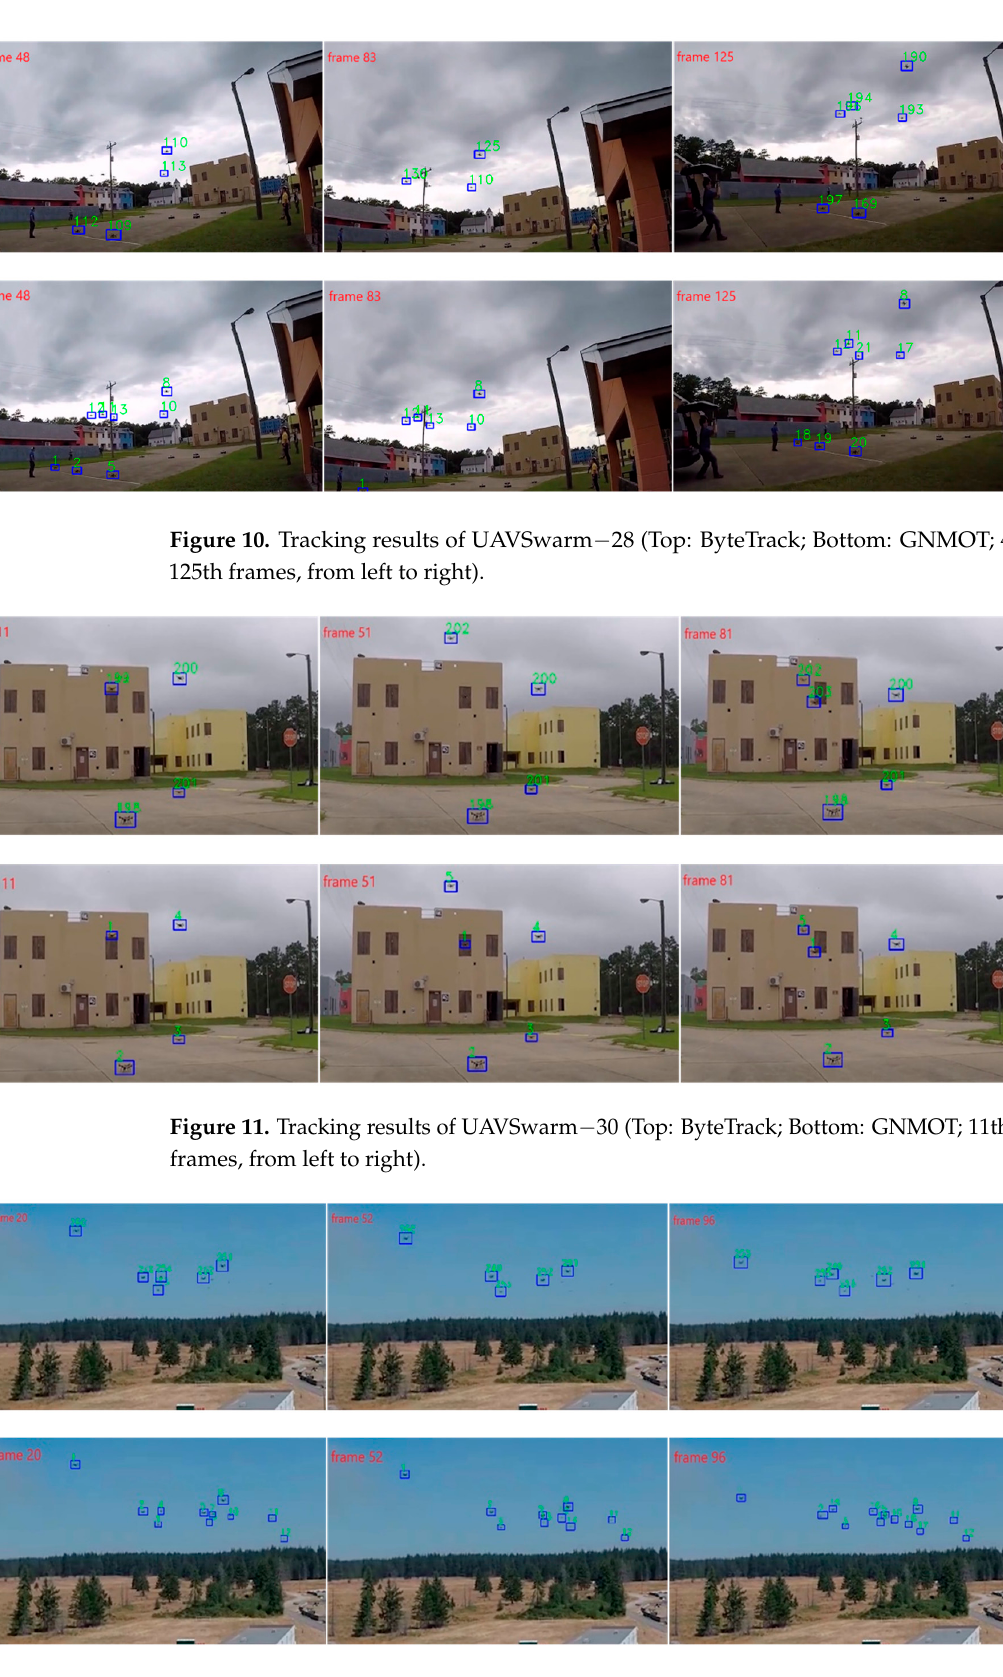
Figure 12. Tracking results of UAVSwarm − 46 (Top: ByteTrack; Bottom: GNMOT; 20th, 52nd, and 96th frames, from left to right).